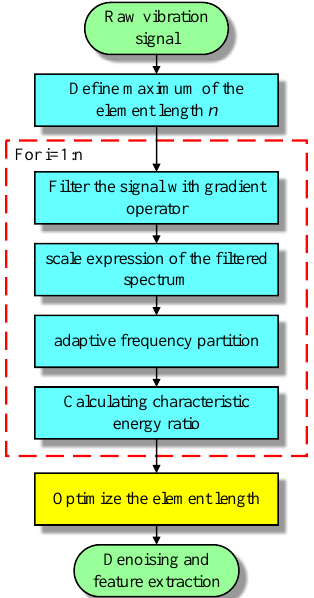
Figure 5. The flow diagram of the proposed method.